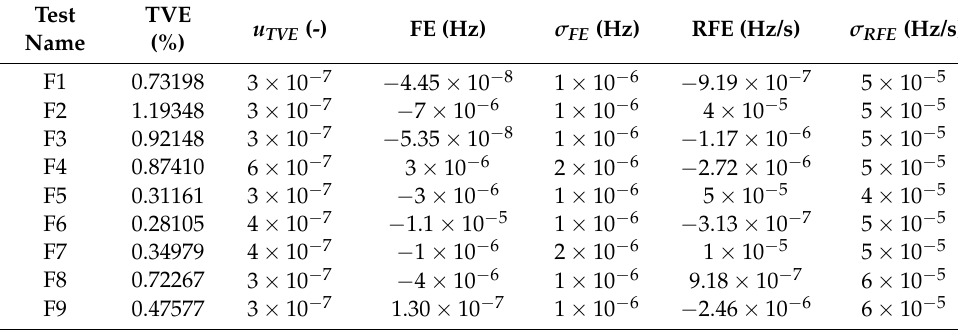
Table 20. Measurement results of the frequency